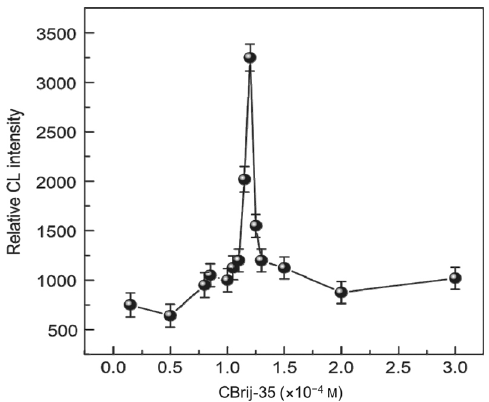
Figure 5: CL intensity of the luminol-H Reprinted with permission from Zhao et al.